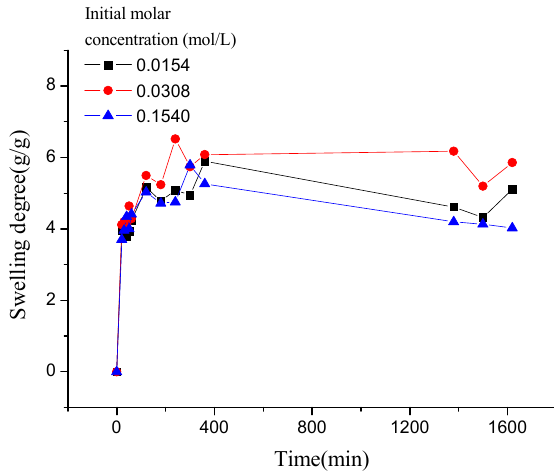
Figure 11. The swelling kinetics of γ -PGA/ ε -PL hydrogels in CrCl 3 solution.